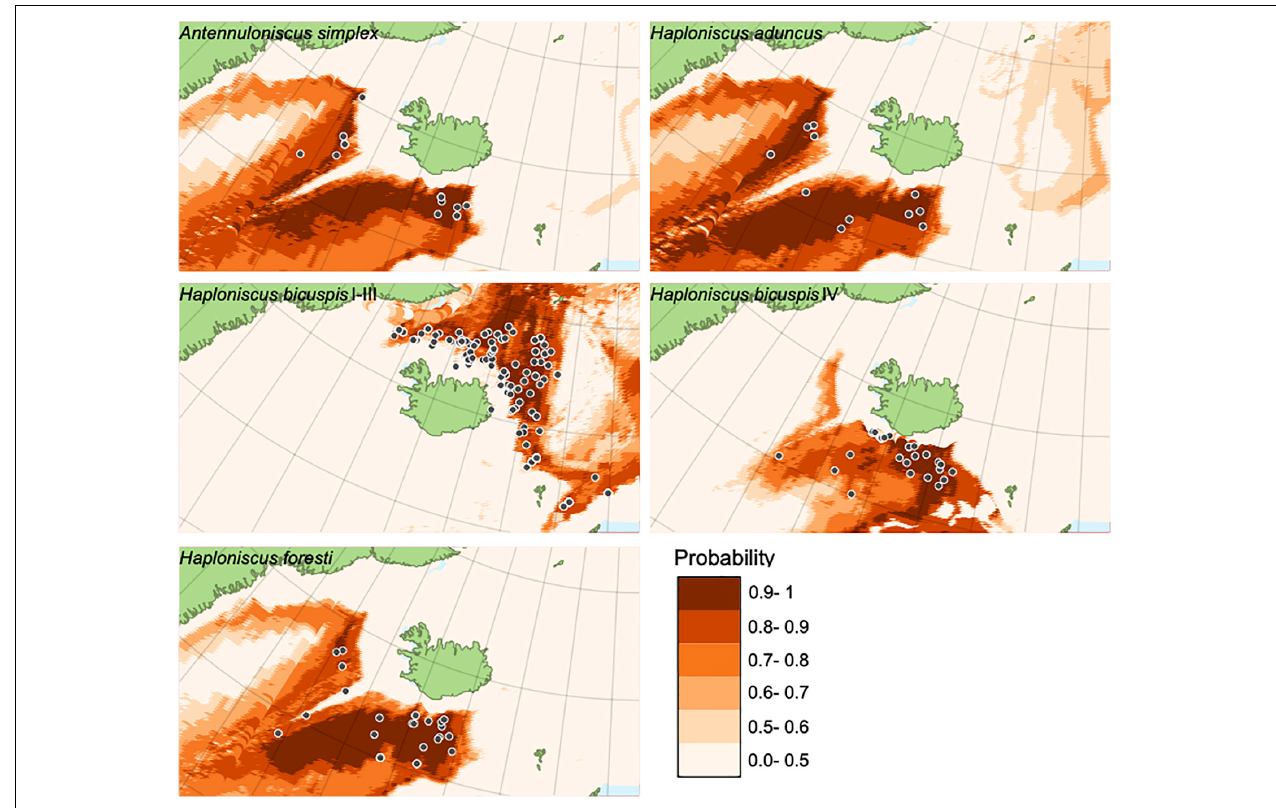
FIGURE 11 | Statistically significant species distribution models of Haploniscidae species around